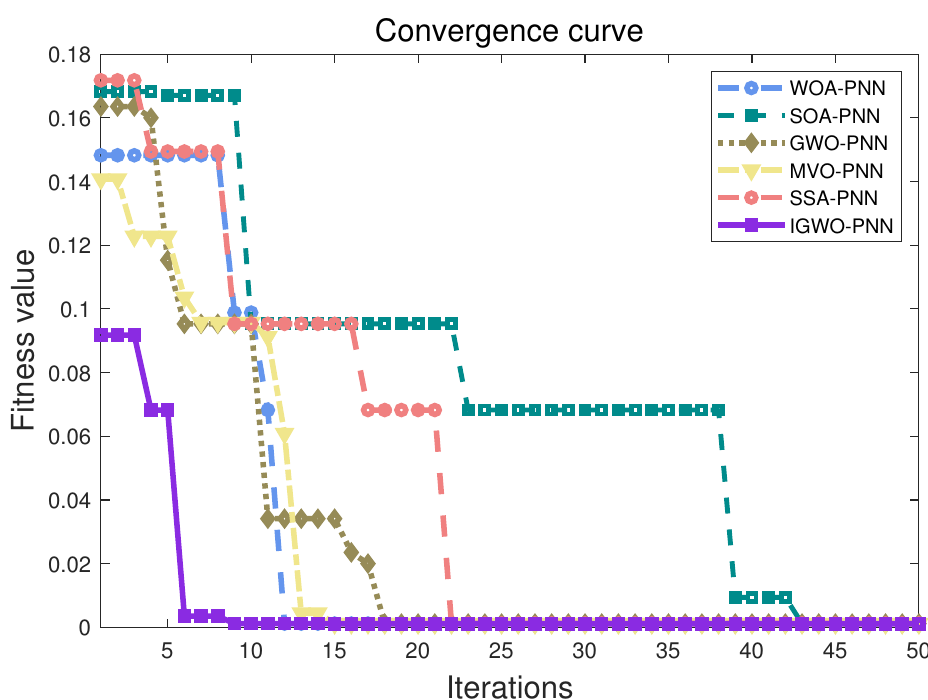
Figure 10. The fitness curve of different methods in the second set of comparative experiments.